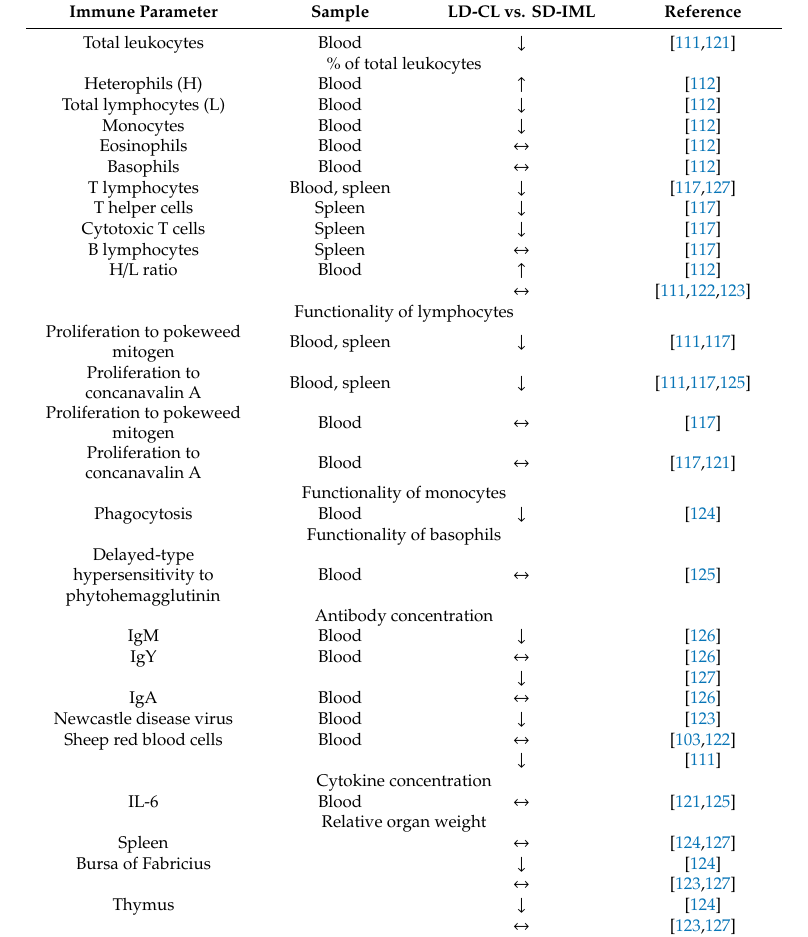
Table 3. Alterations of immune parameters in chickens housed under long-day conditions with constant lighting (LD-CL) compared to short-day conditions with intermittent lighting